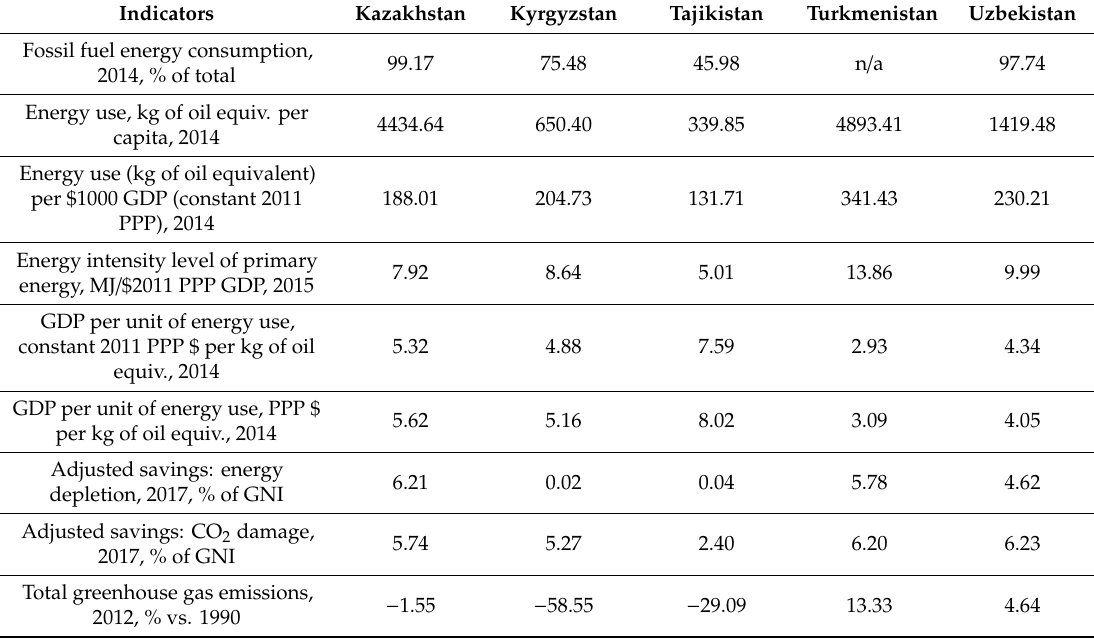
Table 4. Environmental Sustainability (Source: author, based on World Bank data). Indicators